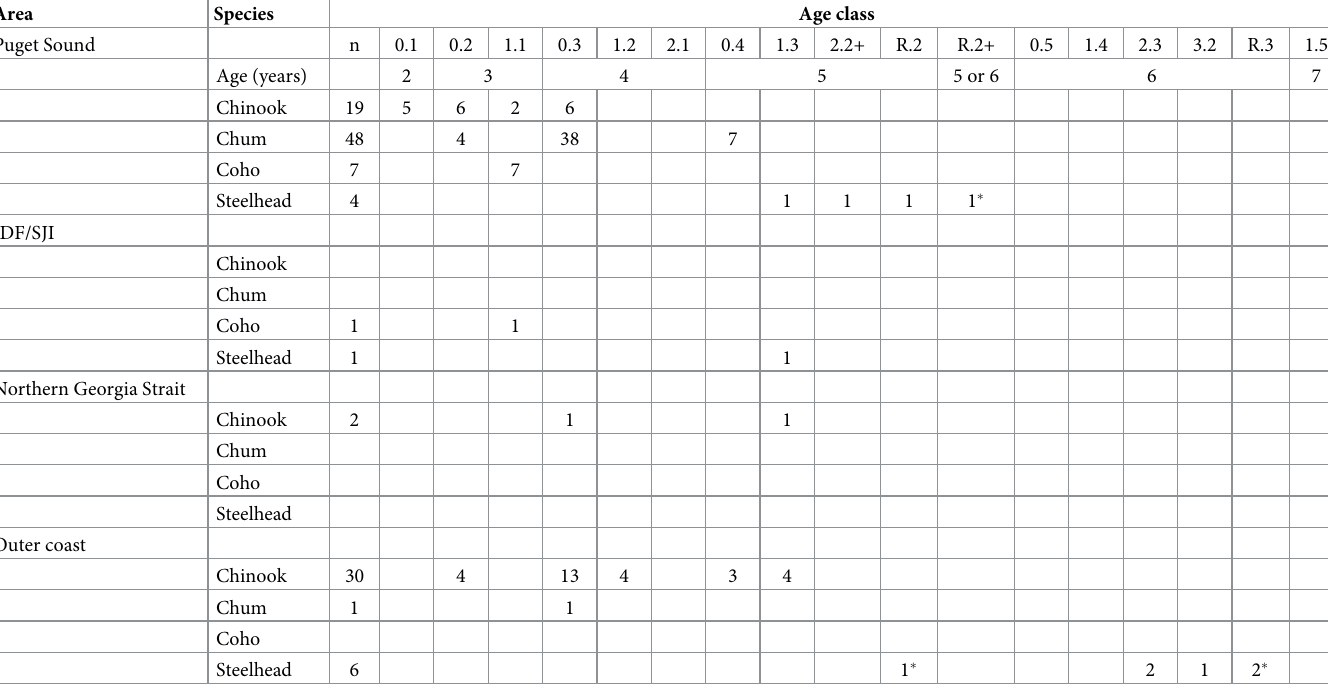
Age class given in European system, whereby years in freshwater after hatching and years in salt water are identified and separated by decimal point. Ages used elsewhere in this paper were obtained by summing the two European age values and adding 1 (e.g. 1.2 age converts to a 4th year fish). An “R” indicates that the freshwater age could not be estimated due to scale regeneration. Specific names of prey in Table 2. � The total age of these steelhead is assumed to have a freshwater age of